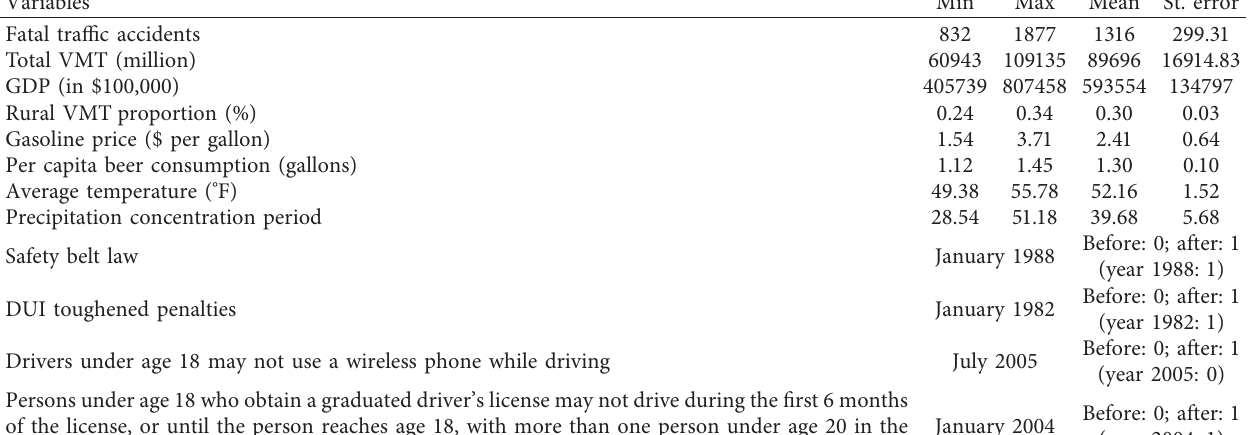
Table 1: Summary statistics of annual fatal traffic accidents and factors in